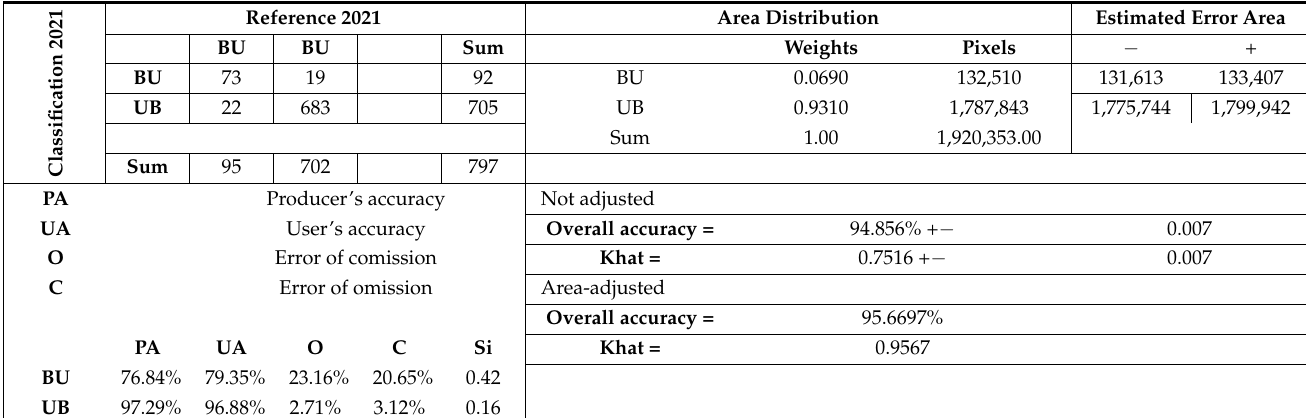
Table A4. Confusion matrices for 2021. BU: burned, UN: unburned.